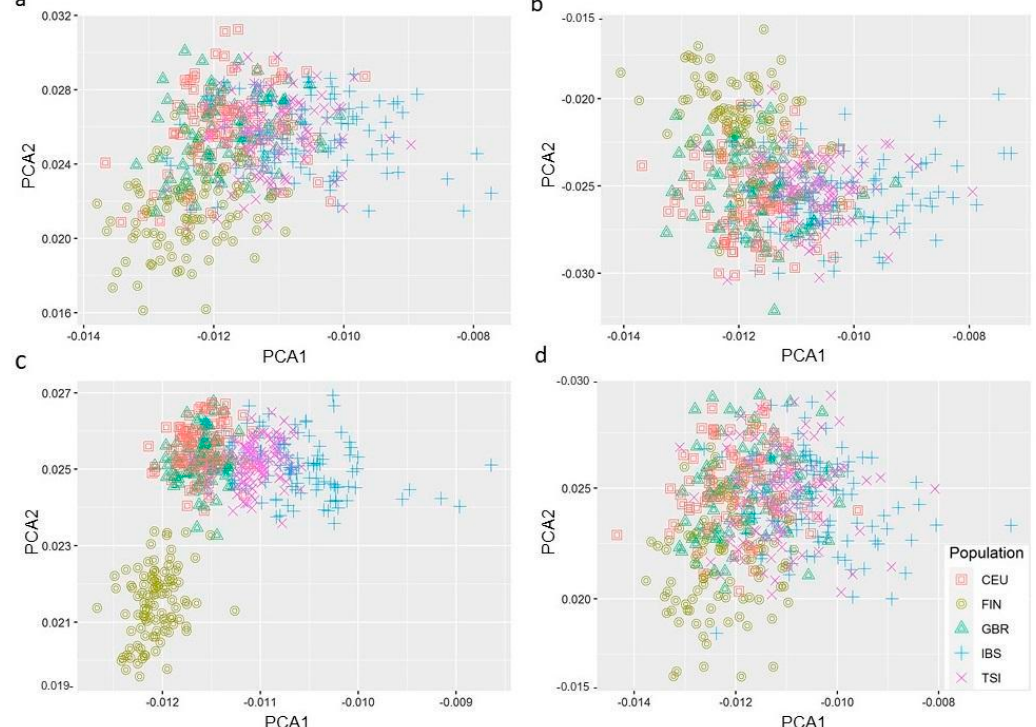
Figure 3. Principal component analysis from five European ancestries for the following canonical signalling pathways: ( a ) Caveolar-mediated Endocytosis ( b ) MS P- RON Signalling ( c ) Hepatic Fibrosis/ Hepatic Stellate Cell Activation ( d ) Communication between Innate and Adaptive Immune cells. The populations include CEU: Utah residents with Northern and Western European Ancestry, FIN: Finnish population, GBR: Great Britain (England and Scotland), IBS: Iberian (Iberian Population in Spain), TSI: Tuscany (Tuscany in Italy). Genes obtained from pathway analysis (IPA, Qiagen) and gene locations (GRCh37/hg19 built) included a ± 1 Mb window. Genome data outsourced from 1000 G phase III v.5b. PC analysis. PC analysis was performed using PLINK software v1.9b.